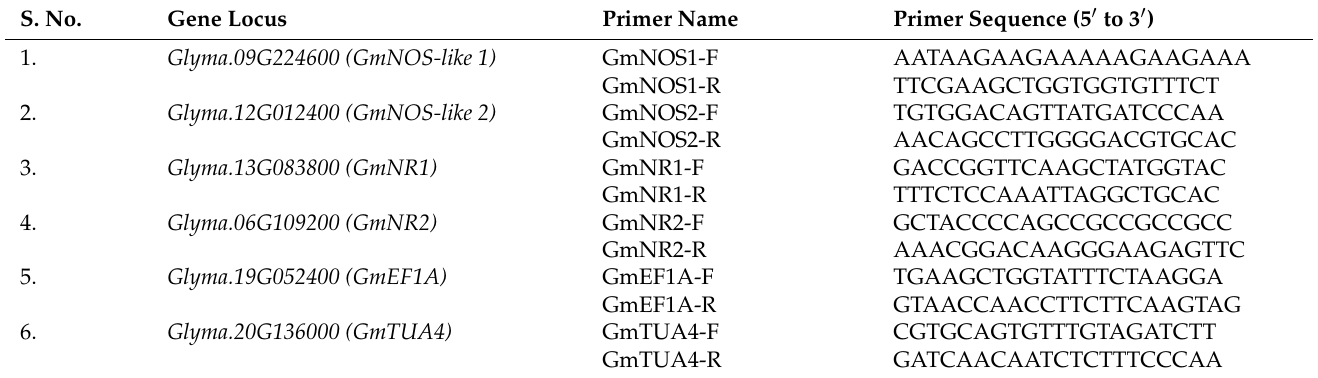
Table 2. Primers used in the present